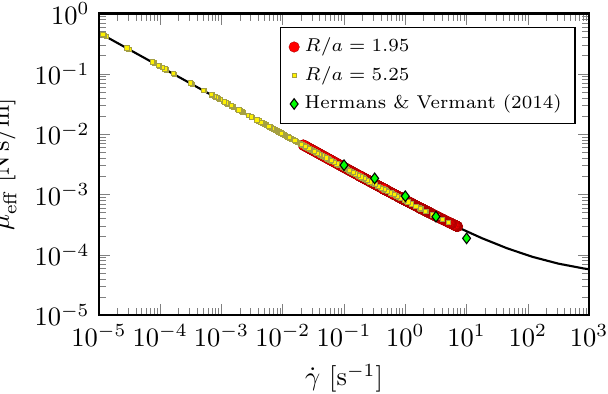
Figure 7. Effective measured viscosity of DPPC monolayer at surface pressure Π = 40mN/m, determined from the experimental interfacial velocity profiles shown in Figure 6. The black curve µ s computed from the non-Newtonian model [36], and the green diamond symbols are data from [57] taken in a double-wall ring apparatus with DPPC at Π = 40mN/m. (Reproduced with permission from [36], published by American Physical Society